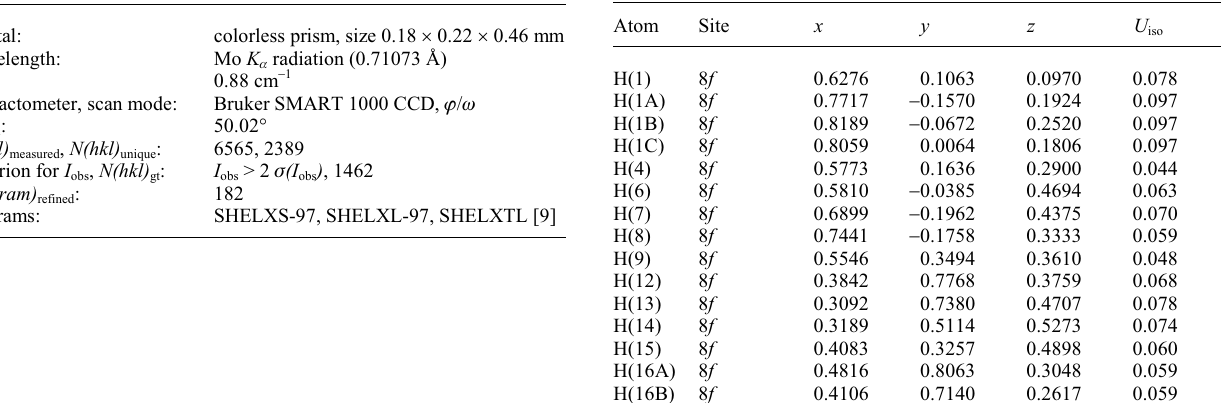
Table 2. Atomic coordinates and displacement parameters (in Å 2 ) . Table 1. Data collection and